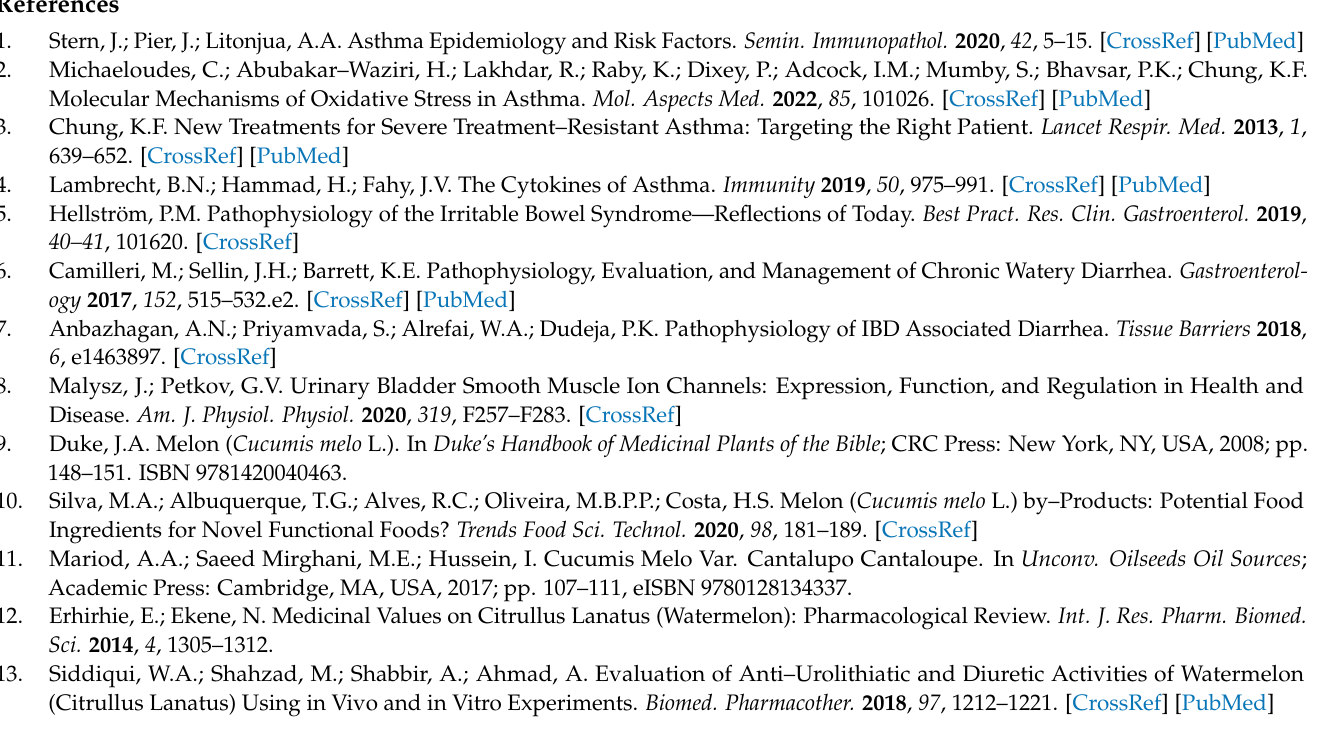
enrichment; Figure S10. 2D ligand-protein interaction between bioactive compounds of C. melo seed sequential extracts and proteins; A. Interleukin 2 Receptor Subunit β (IL2RB) B. Nitric Oxide Synthase 2 (NOS2) C. Voltage-dependent L–type calcium channel subunit alpha 1C α ; Table S1. Identification of phytoconstituents of C. melo seeds extracts with LC ESI-MS/MS; Table S2. Precision validation of analytical method C. melo seed extracts; Table S3. Accuracy validation of analytical method of C. melo seed extracts through % recovery method; Table S4. Network analysis of pathogenic target genes interaction with phytoconstituents; Table S5. The binding energies (kcal/mol) of docked ligand-protein complex calculated with Prime